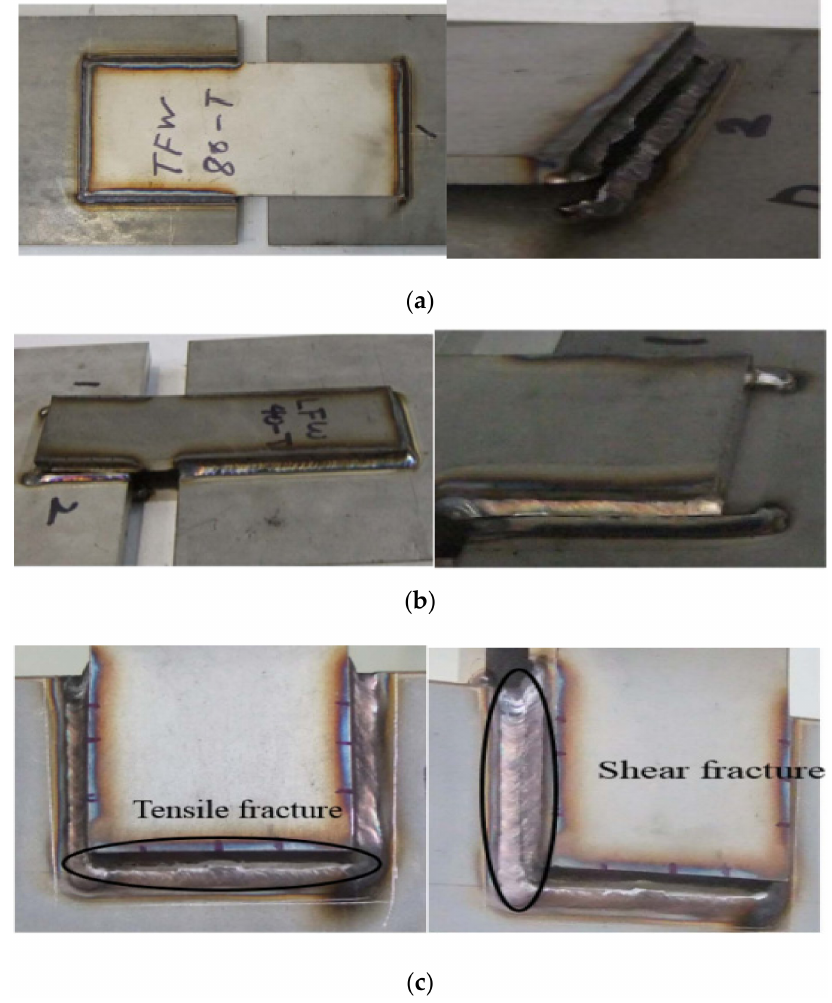
Figure 6. Block shear fracture for fillet welded joints [27]. ( a ) Transverse fillet weld (tensile fracture); ( b ) Longitudinal fillet weld (shear fracture); ( c ) Full fillet weld (block shear fracture: tensile fracture → shear